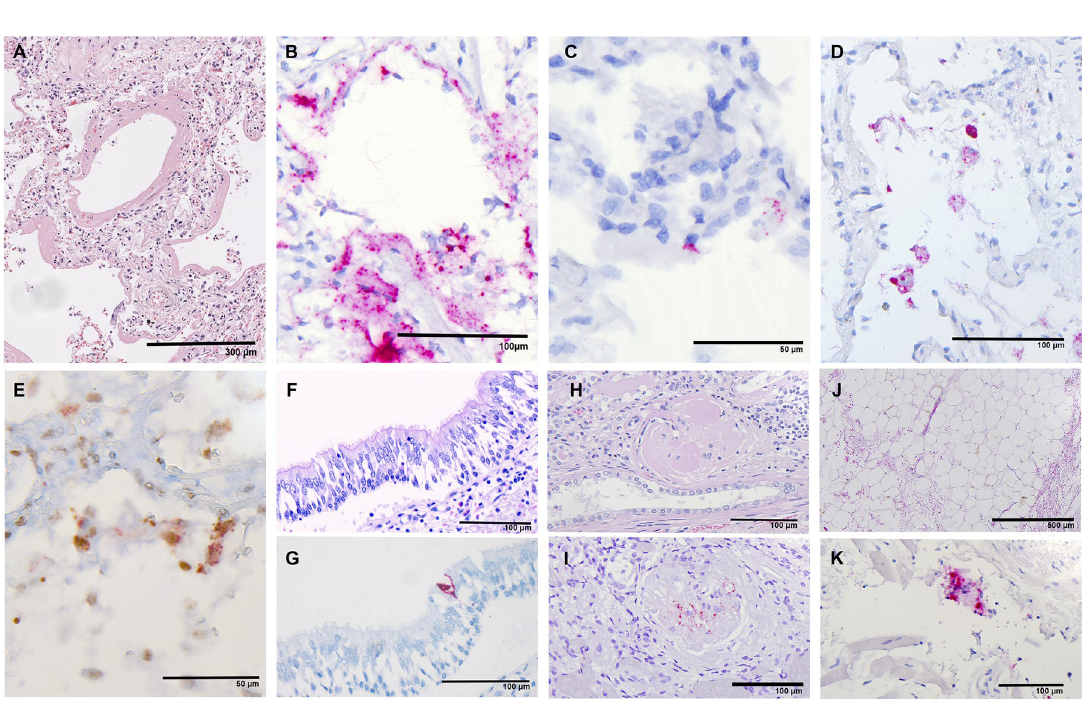
Fig 5. Representative microscopic images. A) H&E–Lung sample (case 8) with an early DAD with broad hyaline membranes, broadening of the alveolar septa, and mild lymphocytic inflammation. B) RNA-ISH positive-sense–same case as A); remarkable extensive SARS-CoV-2 detection in pneumocytes and interstitium. C) RNA-ISH negative-sense–the same case as A); negative -sense RNA is observed only in a few cells. F) H&E and G) RNA-ISH positive-sense; Conventional staining shows a normal mucosa with well- preserved respiratory epithelium. Detection of single infected cell with RNA-ISH. H) H&E and I) RNA-ISH positive-sense; Sclerosed gleomerulus with several infected cells. J) H&E and K) RNA-ISH positive-sense; Adipose tissue with mild hemorrhagic alteration but without relevant inflammation. High magnification of this slide reveals a single SARS-CoV-2 positive cell representation probably a histiocyte.